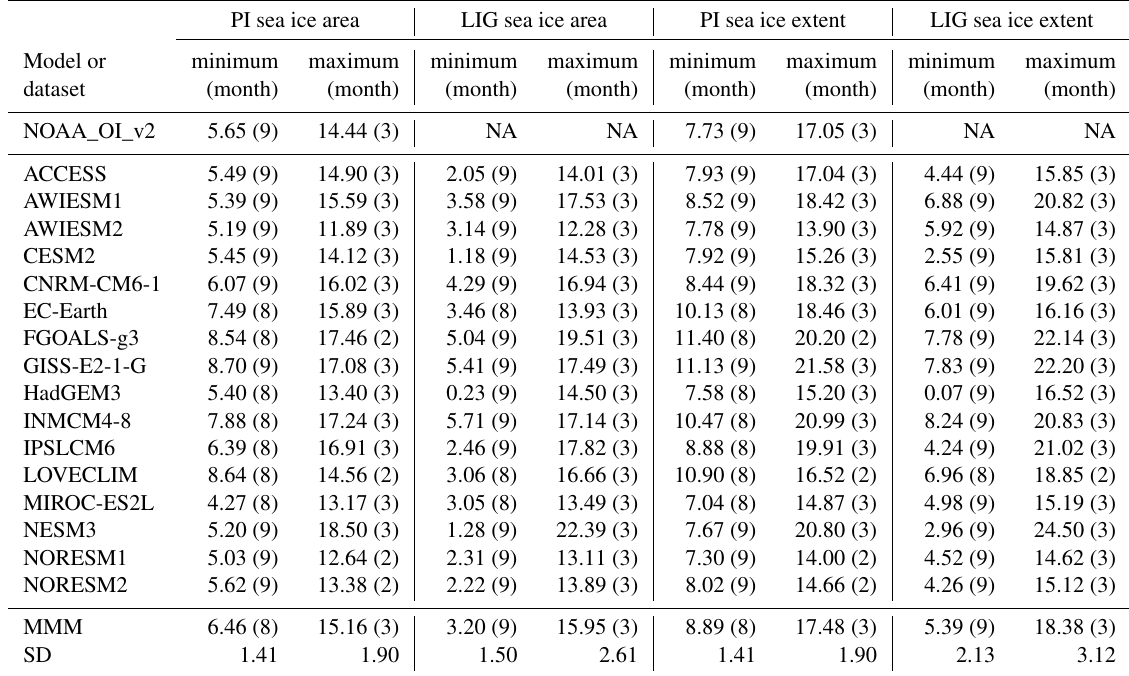
Table 4. Sea ice area and extent (in 10 6 km 2 ) for the PI and LIG simulations (calendar-adjusted values). MMM stands for the multi-model mean, SD for the multi-model standard deviation. NA stands for not